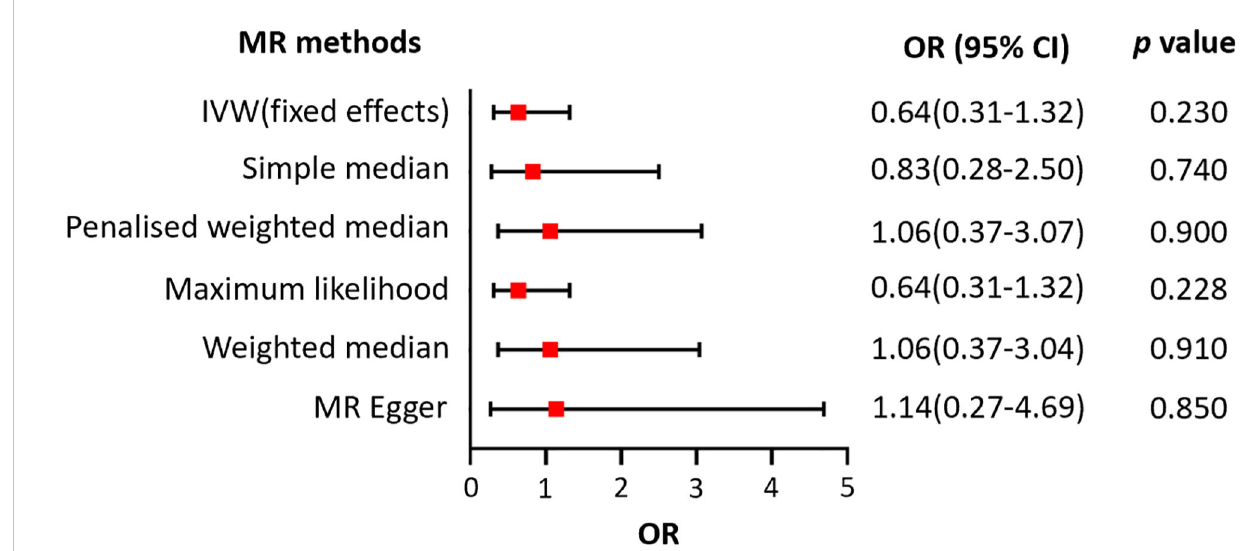
FIGURE 5 Forest plot of the association between genetically predicted telomere length and alopecia